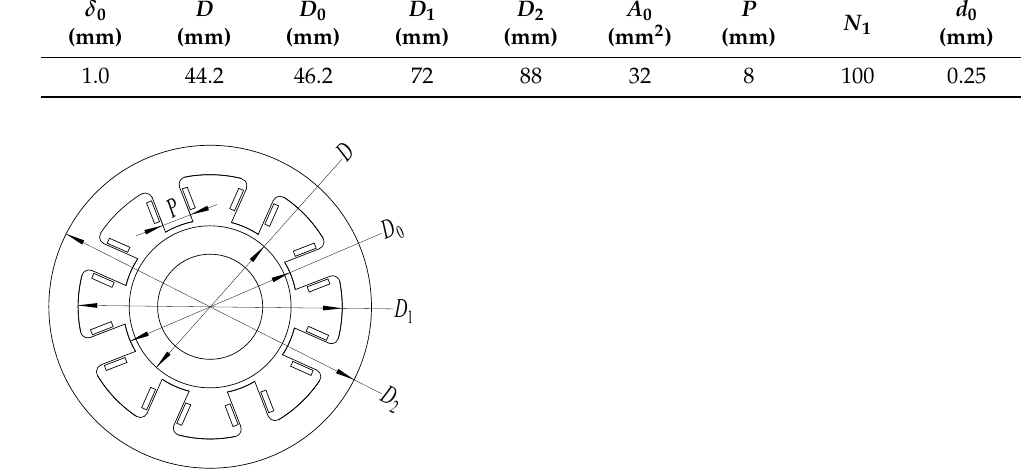
Figure 4. Structure diagram of self-inductive displacement sensor. In the figure: D -rotor diameter; D 0 -inner diameter of stator; D 1 -inner diameter of stator yoke; D 2 -outer diameter of stator; A 0 -magnetic pole area; P -width of pole shoe; N 1 -the number of coil turns; d 0 -diameter of coil wire.